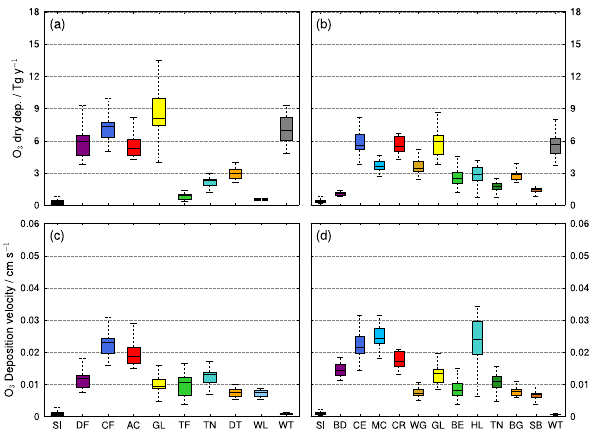
Figure 5. Seasonal amplitude in total global O 3 dry deposition par- titioned to the OW11 (a) and GLCF (b) land cover classes. The monthly range in average O 3 dry deposition velocity is shown in the lower panels for OW11 (c) and GCLF (d) land cover classes. The box and whiskers represent the median, quartiles and 10th/90th percentiles over the model